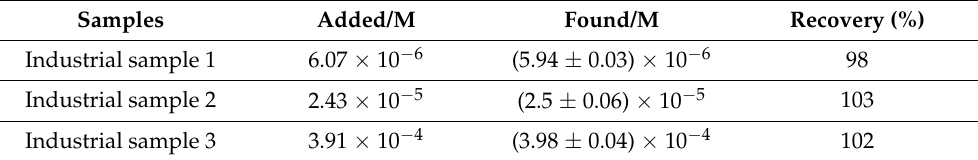
Table 3. Recovery values obtained in the application of the sensor in industrial samples.